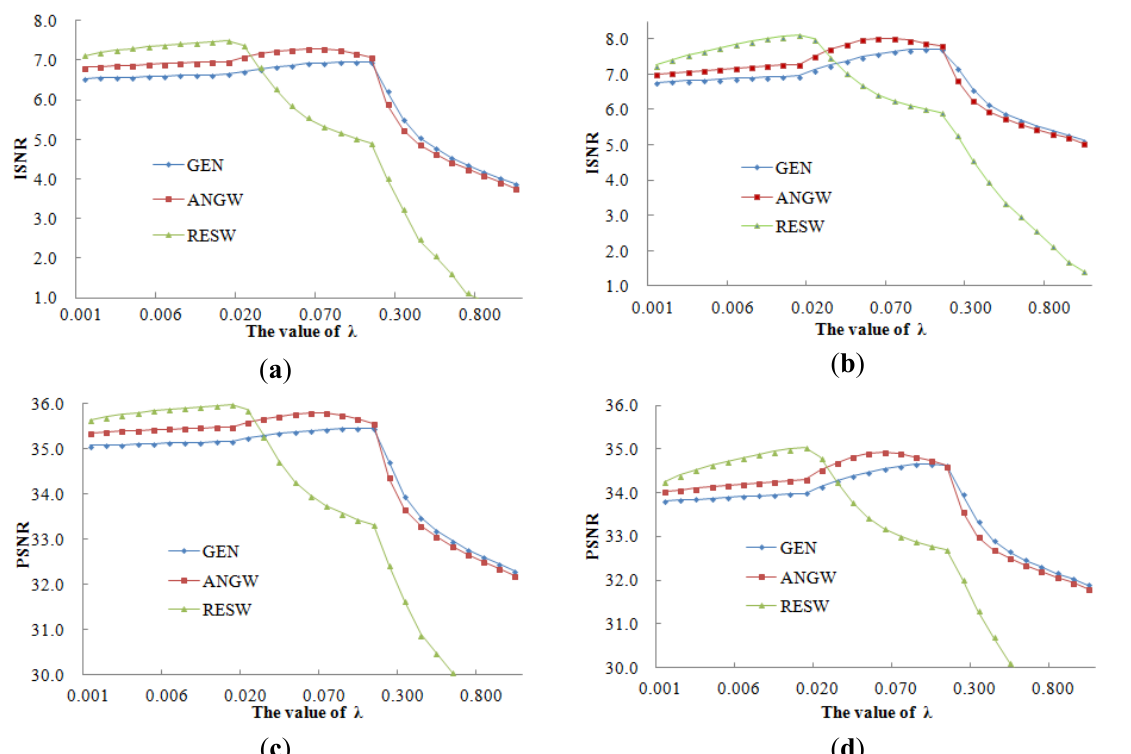
Figure 8. Sensitivity analysis of the regularization parameter λ in terms of ISNR, PSNR and SSIM in the simulation image data experiment. ( a , c , e ) show the ISNR, PSNR, and SSIM values of Image1, respectively; ( b , d , f ) show the ISNR, PSNR, and SSIM values of Image2,